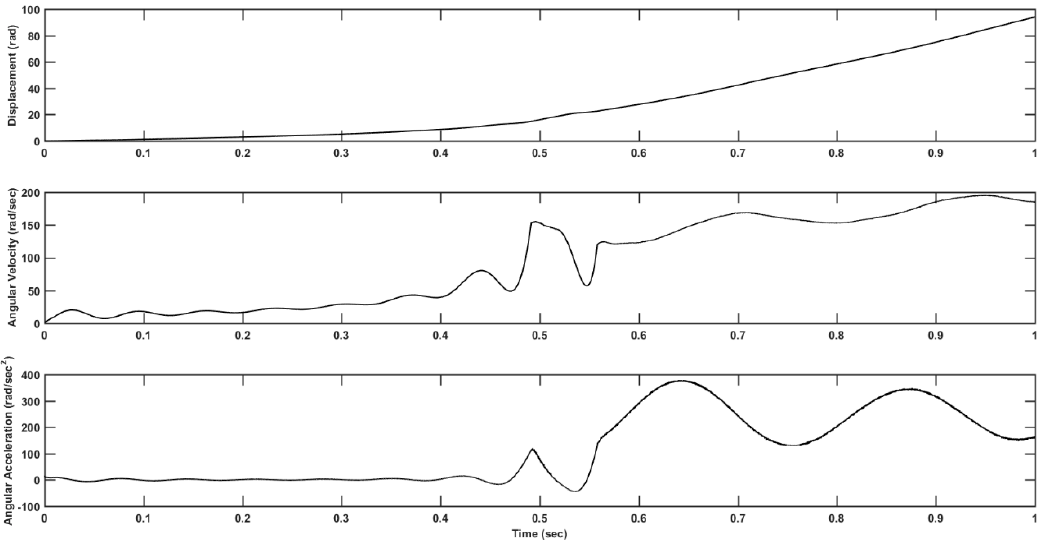
Figure 5. Predicted variations of angular displacement, angular velocity and angular acceleration for the new friction lining material during clutch engagement.